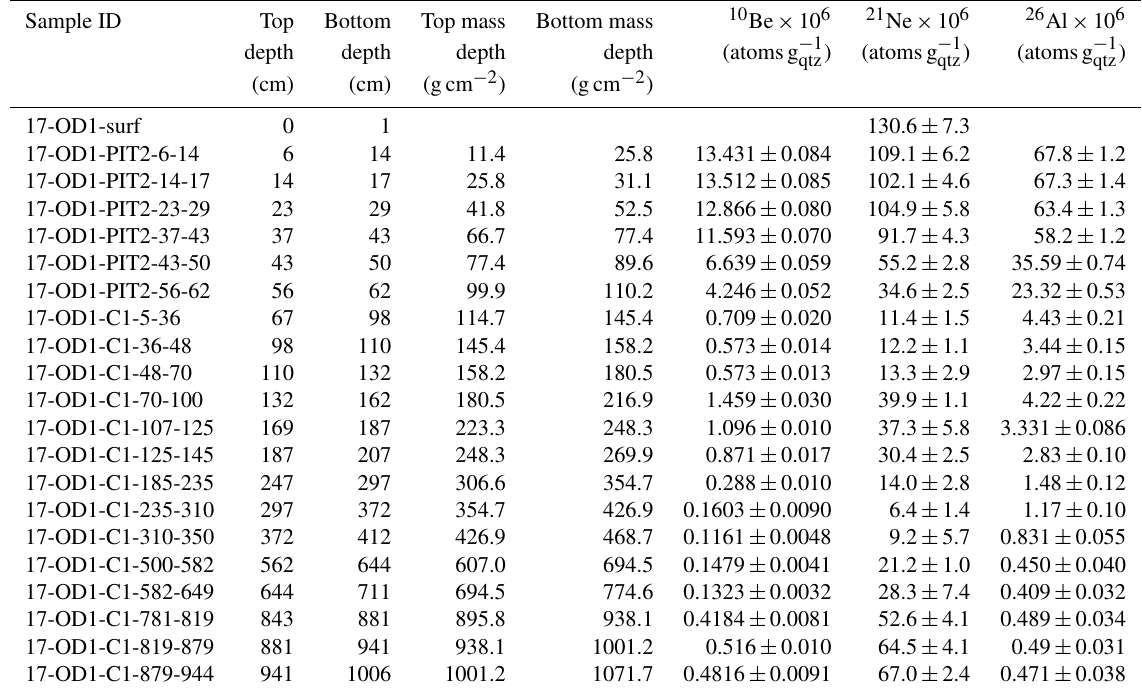
Table 1. Measured cosmogenic nuclide concentrations in quartz extracted from supraglacial debris (prefix 17-OD1-surf/PIT2 ∗ ) and ice core (prefix 17-OD1-C1 ∗